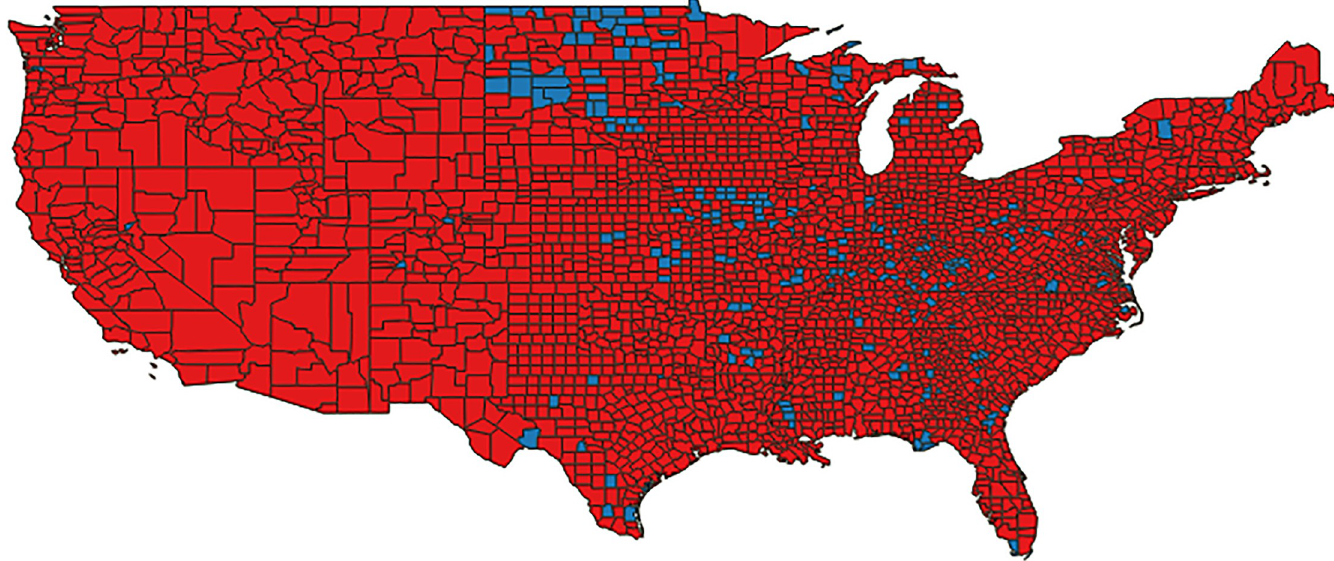
Fig 1. Water stress status of U.S. counties in 2010, a drought year. The majority of counties (2,853) in the continental United States were water stressed (red), while only 256 counties were free from water stress (blue).